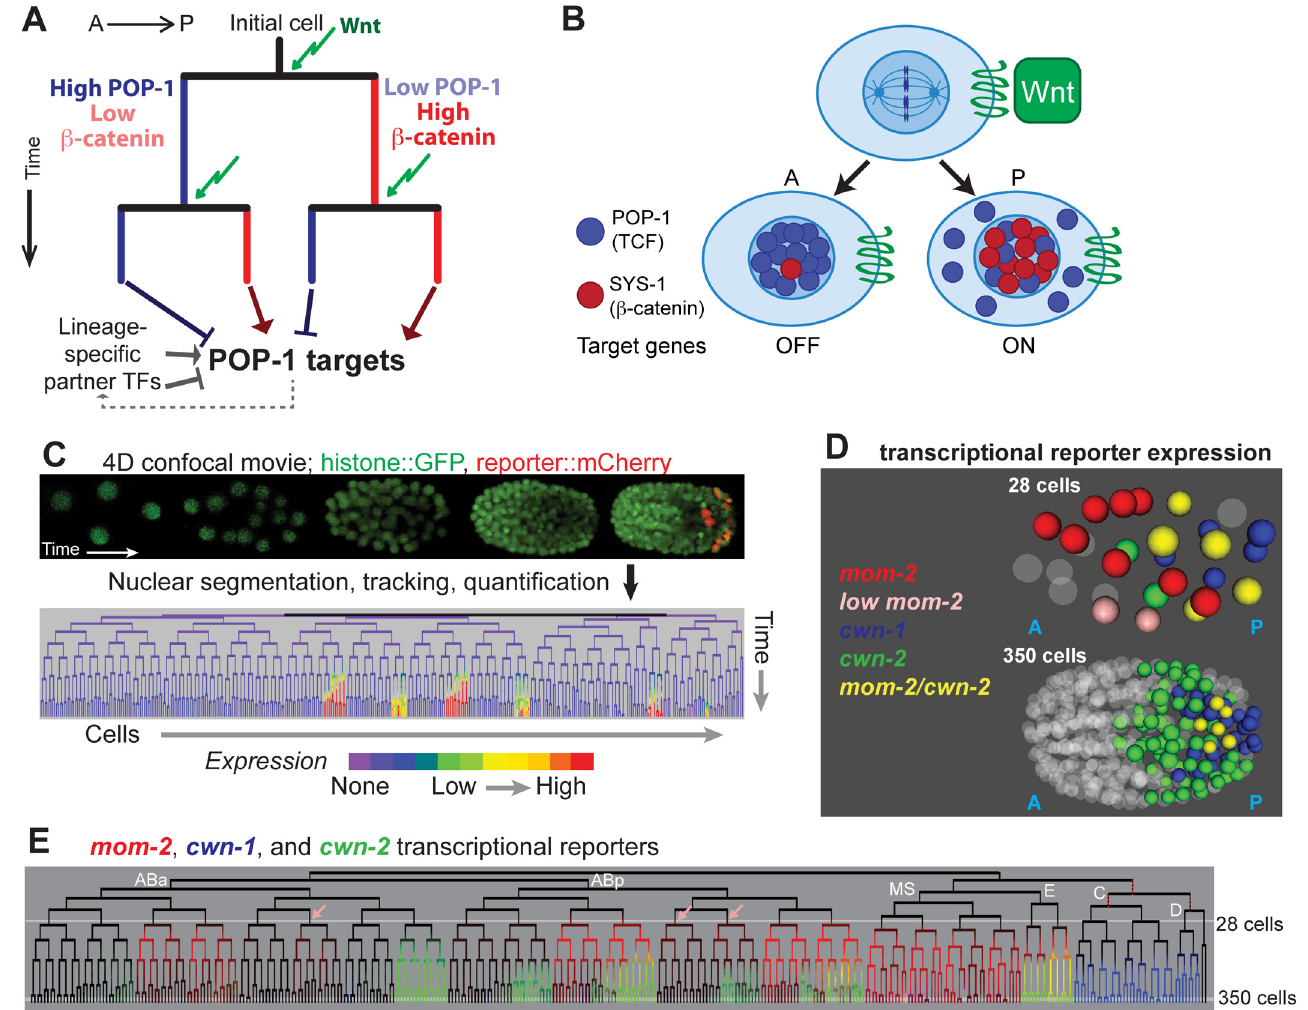
Fig 1. Wnt signaling and sources of Wnt ligand in the early C . elegans embryo. A) Existing model for Wnt-mediated expression. Wnt (green arrow) induces posterior daughters to have high nuclear beta-catenin (red) and low nuclear POP-1 (blue), and the converse in anterior daughters. This results in activation of POP-1 targets in posterior daughters and repression in anterior daughters. The process is repeated in each subsequent division. Since POP-1 targets differ between cells, other factors, possibly themselves POP-1 targets, must provide context information. B) Stoichiometry model of POP-1/SYS-1 target expression regulation. Wnt ligand orients the division axis of a cell and generates an anterior daughter with high nuclear POP-1 and low SYS-1 and a posterior daughter with high nuclear SYS-1 and low POP-1. C) In automated lineage tracing, movies of embryos expressing fluorescent histones ( Pnob-1 shown) is processed by StarryNite cell tracking software [47, 80] to produce a lineage tree with expression quantified at each time point. D) Location of the nuclei expressing the 3 earliest Wnt ligands at the 28 and 350 cell stages. E) Transcriptional reporter expression of the earliest three Wnt ligands: mom-2 (red), cwn-1 (blue) and cwn-2 (green). Lineages expressing low levels of mom-2 are marked with pink arrows. Outside of the E lineage, there is little overlap (yellow) suggesting mom-2 expression is down-regulated as cwn-2 is activated in co-expressing lineages. Known maternal expression of mom-2 is indicated by red dotted lines